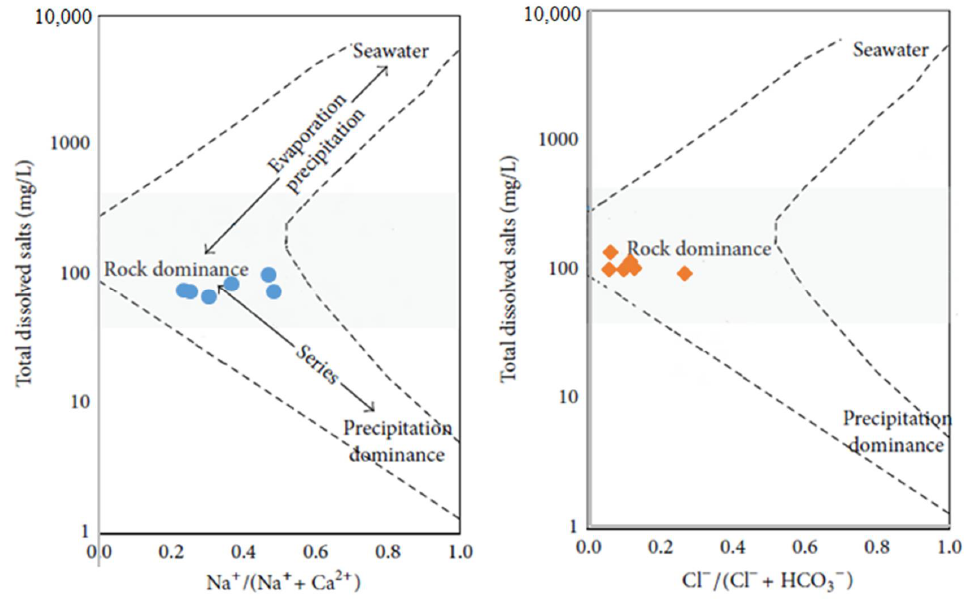
Figure 4. Gibbs diagram indicating the groundwater natural evolution mechanisms.